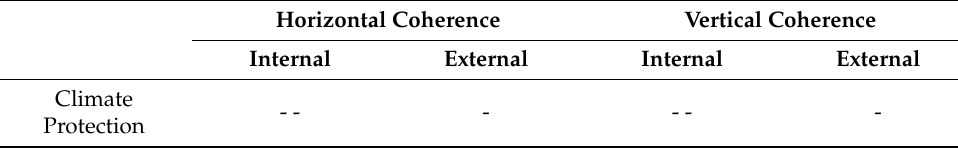
Table 2. Coherence within German climate